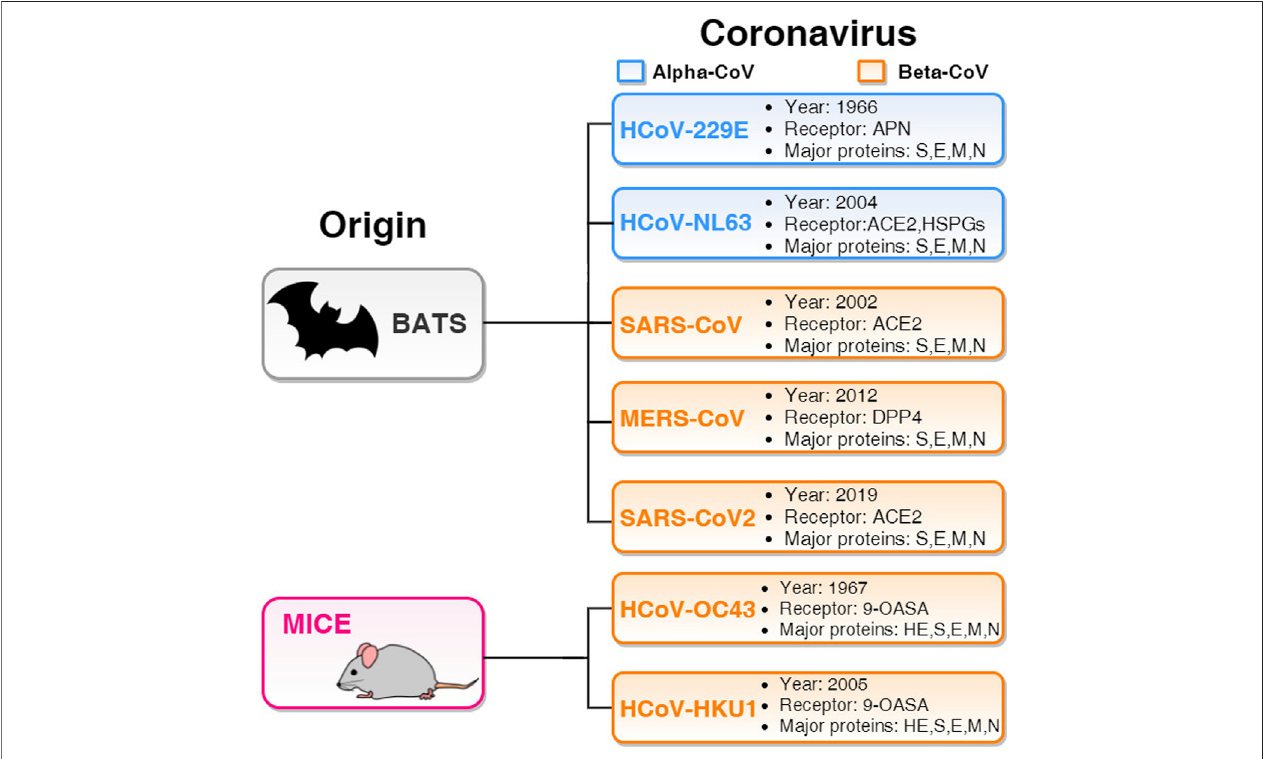
FIGURE 1 | Basic features of seven HCoVs. The two blue panels list alpha-HCoVs and the fi ve orange panels list beta-HCoVs. All the boxes include the year of identi fi cation, receptor, and major proteins. Two beta-HCoVs (HCoV-OC43 and HCoV-HKU1) originate in mice and contain hemagglutinin-esterase (HE) structural protein along with S, E, M, and N. Other fi ve HCoVs originated in bats and have four major structural proteins S, E, M, and